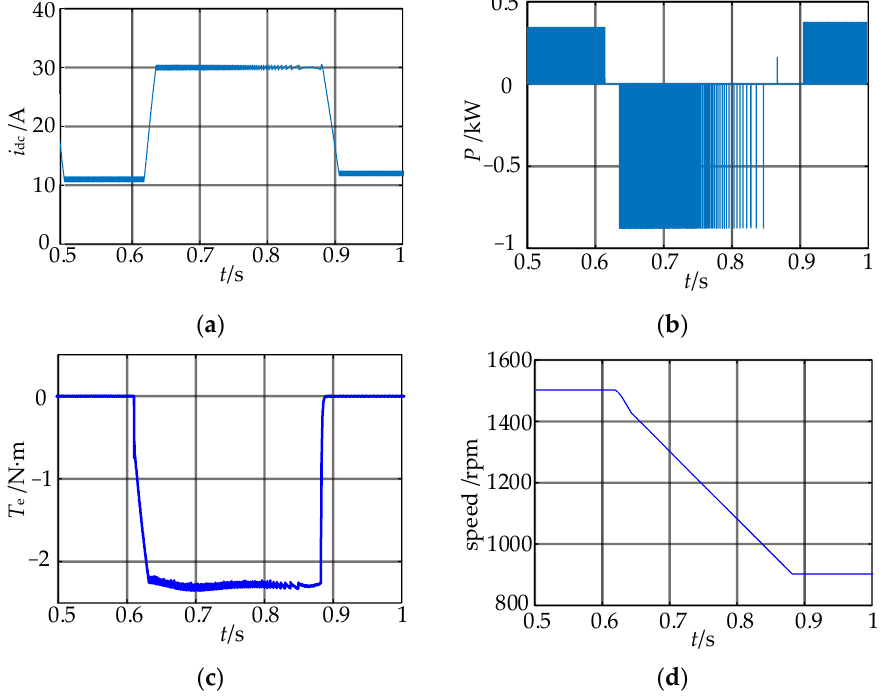
Figure 18. Simulation waveform under no − load deceleration. ( a ) i dc ; ( b ) output power of DC power supply; ( c ) T e ; ( d ) speed. supply; ( c ) T e ; ( d )